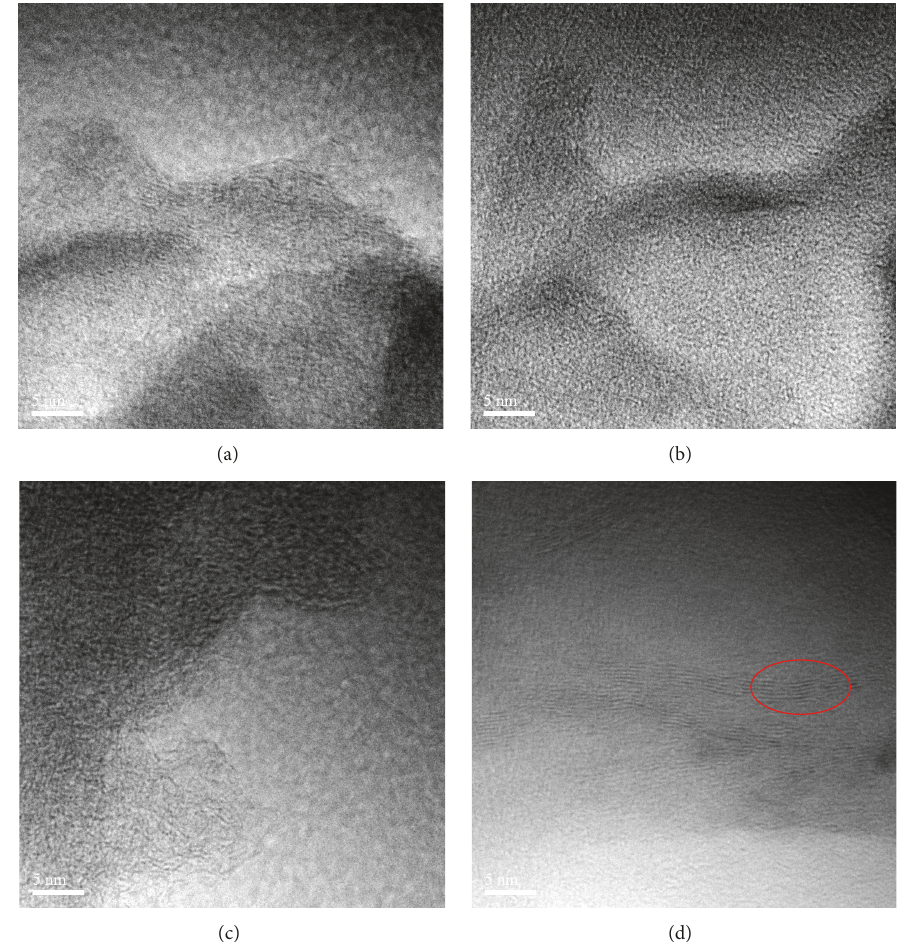
Figure 5: TEM images of activated carbon xerogel ACX-700 (a), ACX-800 (b), ACX-900 (c), and ACX-1000